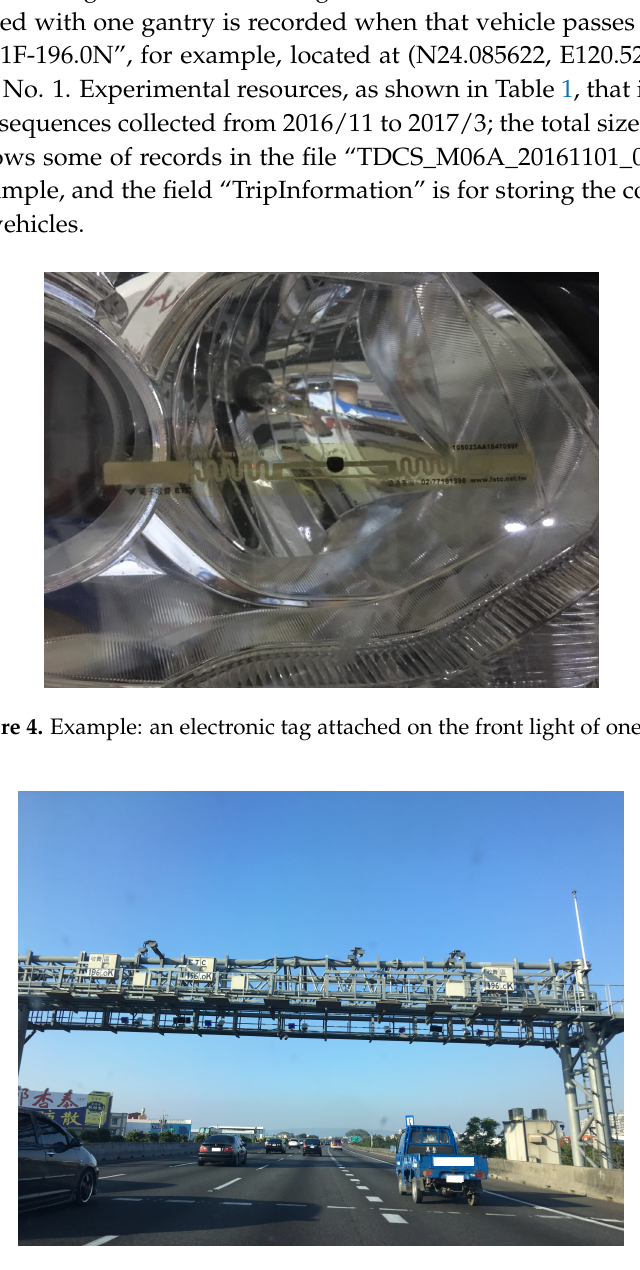
Figure 5. Example: one gantry “01F-196.0N” in the northern direction of Freeway No.